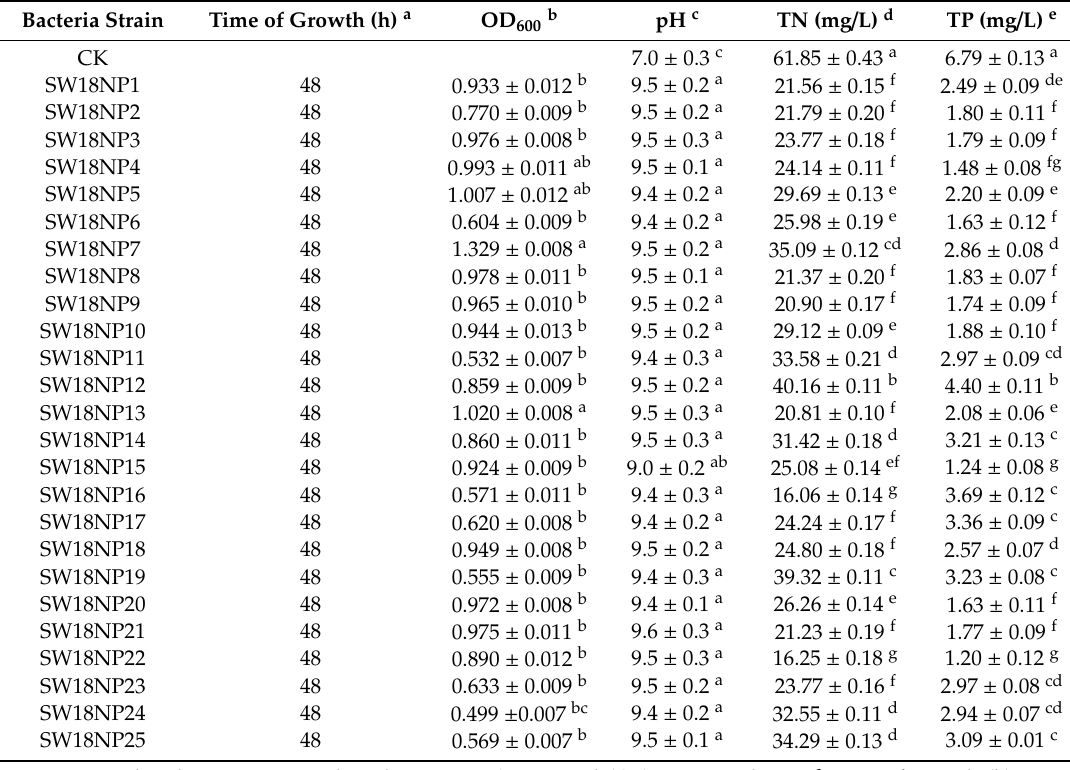
Table 2. The amounts of P-uptake, amounts of TN-liberated, OD, pH, and time of growth. Bacteria Strain Time of Growth (h)